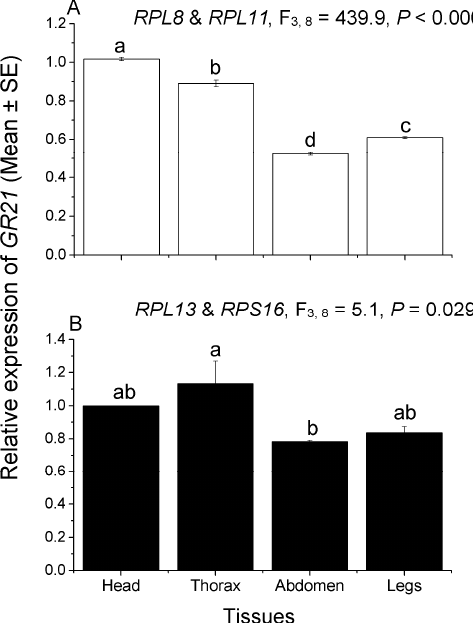
Figure 5. Tissue expression patterns of GR21 gene in C. hemipterus . The relative expression levels of GR21 in the head (including antennae and mouthparts), thorax, abdomen, and legs were normalized to the top two most stable (A, RPL8 and RPL11 ) and least stable (B, RPL13 and RPS16 ) candidate reference genes, respectively. Different lower letters above bars represent significant differences in gene expression among different tissues ( p < 0.05, Tukey’s HSD